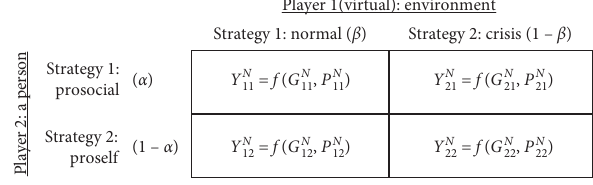
Figure 4: Simplified game